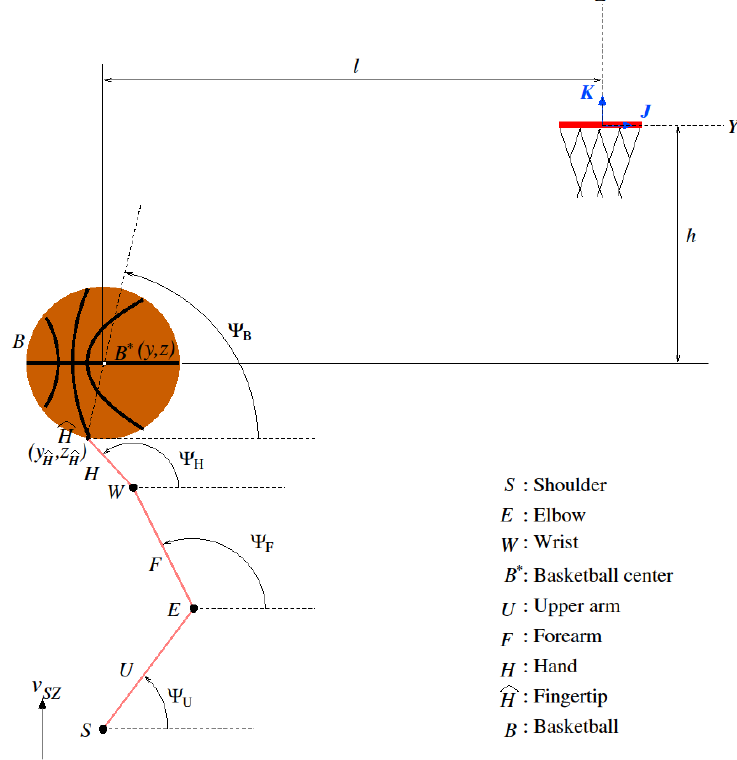
Figure 1. Geometry of shooting arm motion with a